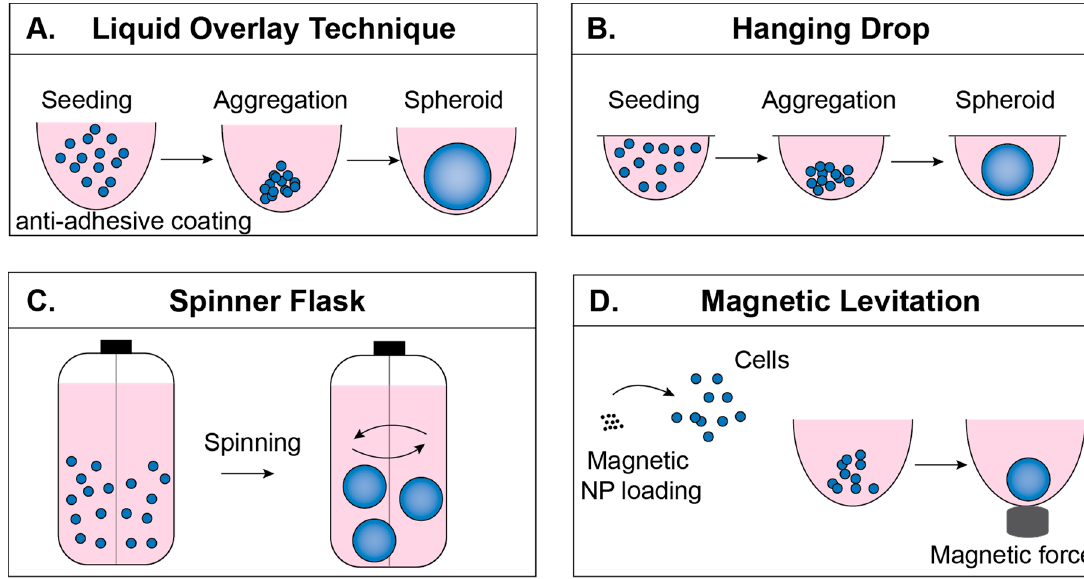
Figure 2. Matrix-free formation techniques. ( A ) In the liquid overlay technique (LOT), cells are seeded onto a surface that prevents adhesion, encouraging cell–cell adhesion. ( B ) In the hanging drop technique, cells are suspended in drops from the underside of a culture plate lid. ( C ) In the spinner flask technique, rotational motion encourages cell–cell adhesion. ( D ) In the magnetic levitation technique, cells take in magnetic nanoparticles and are aggregated by magnetic force.